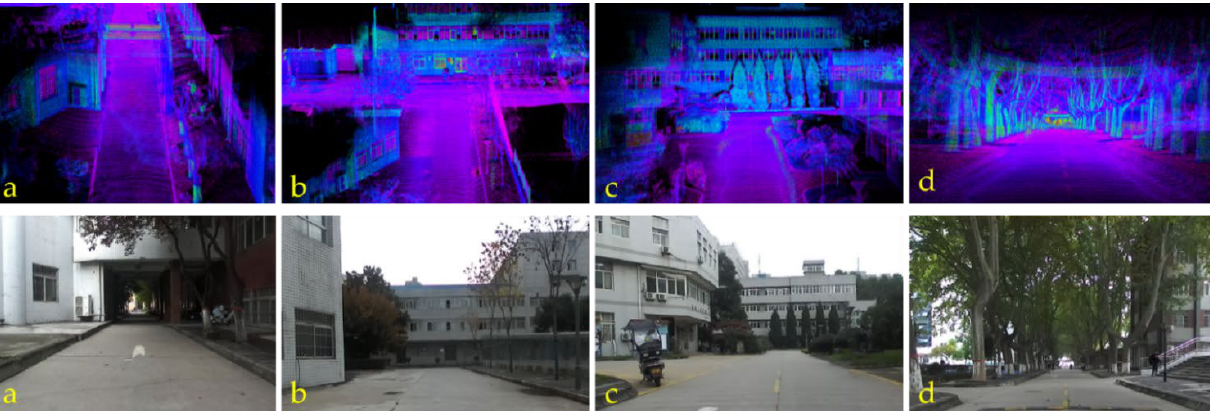
Figure 7. The mapping results in the campus environment; ( a – d ) shows the point cloud map of the LiDAR and the matched image information. The shooting position is shown in four places ( a – d ) in Figure 6.